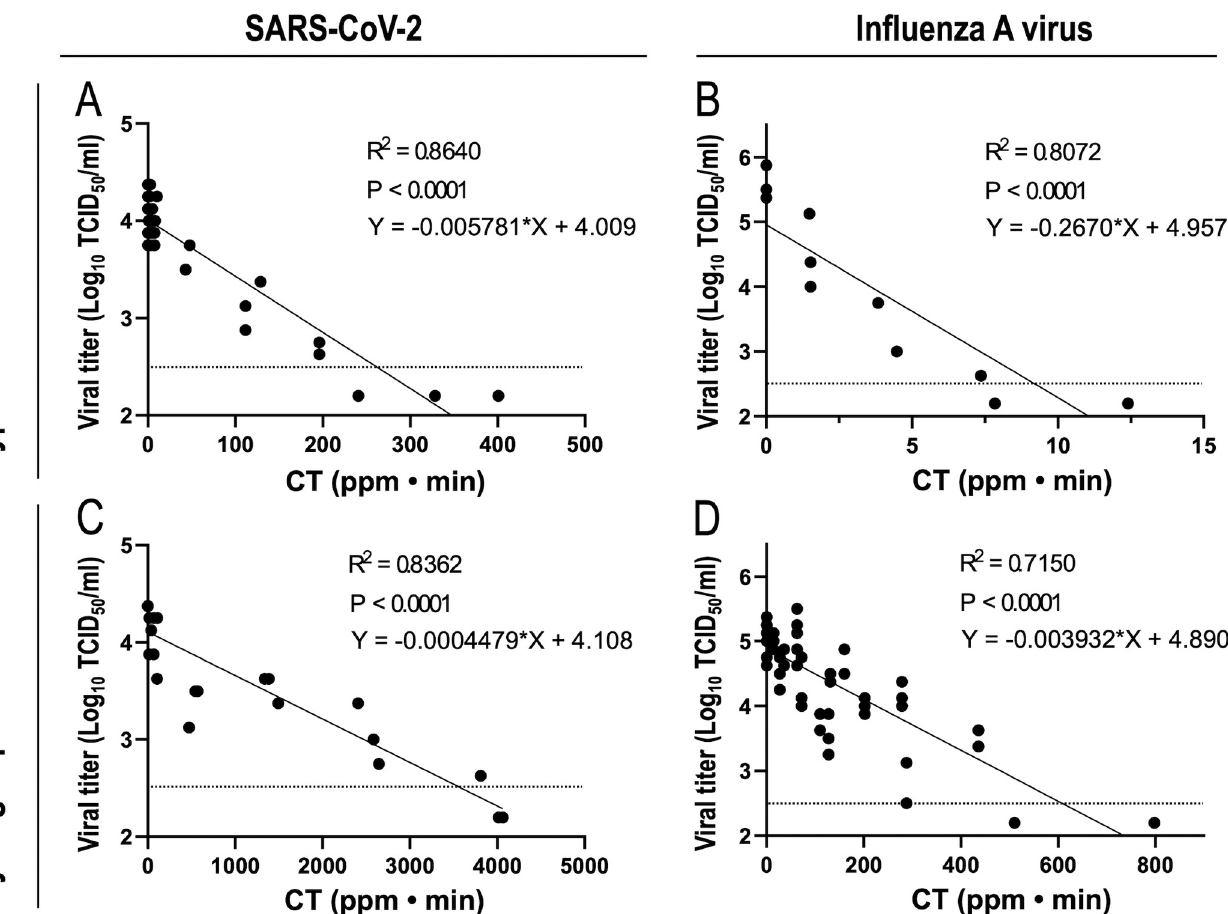
Fig 5. The relationship between virucidal effects of a disinfectant and the CT value. Changes in the viral infectious titers (TCID 50 values) of SARS-CoV-2 (A and C) and influenza A virus (B and D) upon dry fogging with hypochlorous acid solution (A and B) or hydrogen peroxide solution (C and D) were evaluated, as described in the Materials and methods. The CT value of a dry fogged disinfectant was calculated, and a scatter plot was created from each dataset of the viral infectious titer and CT value for the combination of the virus and disinfectant. R squared (R 2 ) values, equations, and p values were estimated using a simple linear regression analysis and reported on the graphs. Horizontal dotted lines in the graphs show the detection limit of the viral titer.